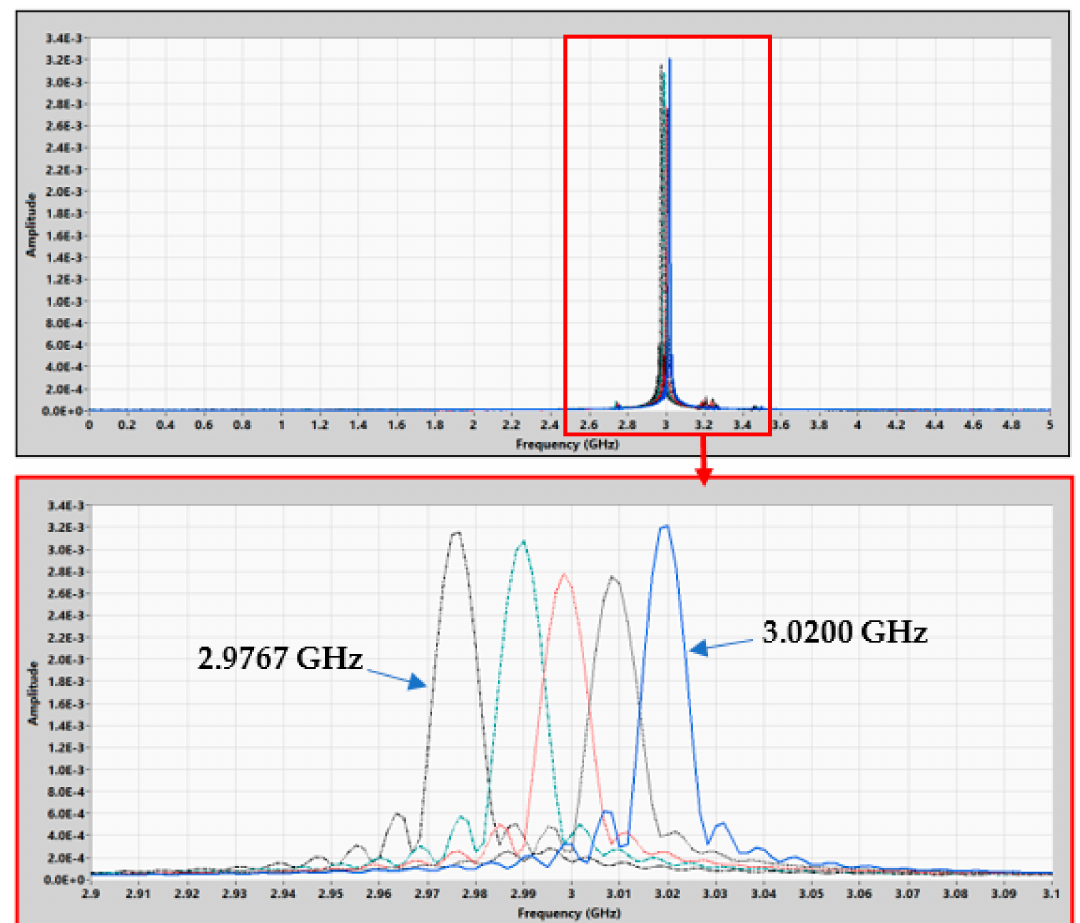
Figure 20. The spectrum of the resonant frequency of each cavity radius with tuner distance of 3.97